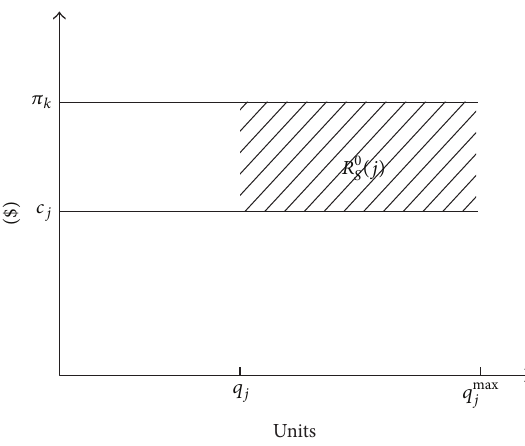
𝑅 0 (𝑗) for rejected, competitive sell offer. 𝑆